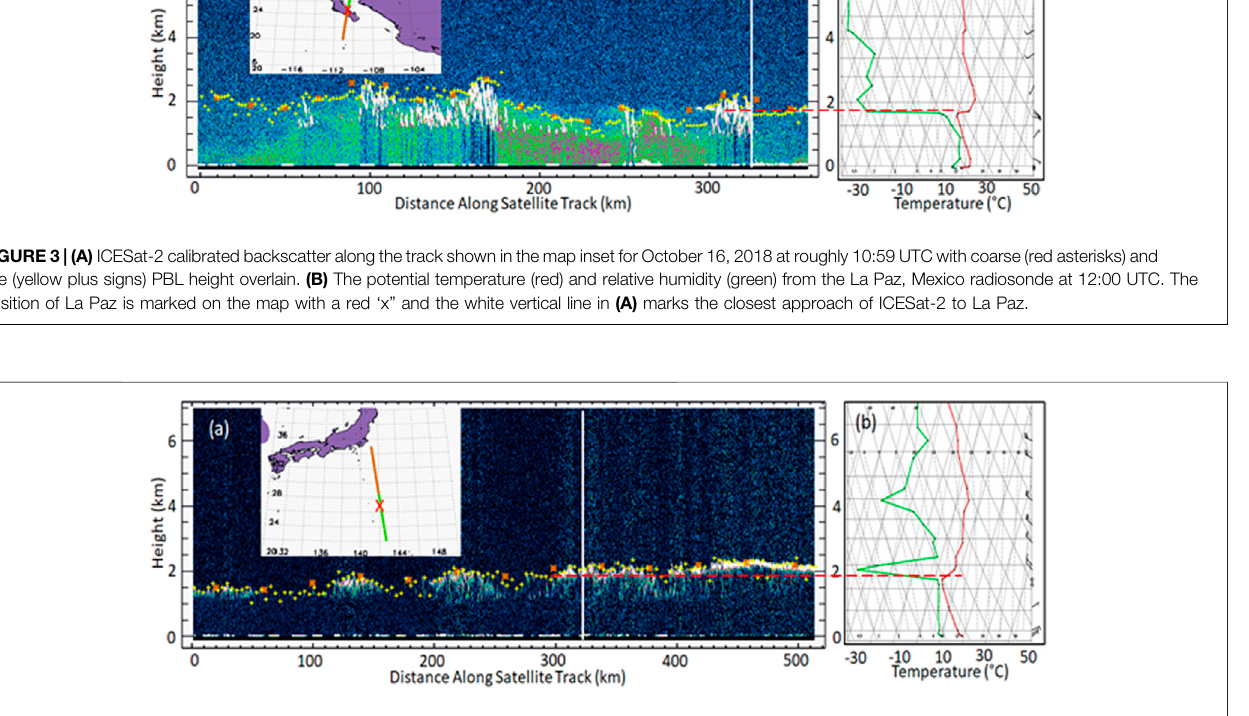
FIGURE 4 | (A) Same as Figure 3 except for an ICESat-2 pass on January 10, 2019 at 01:45 UTC over Chichijima, Japan and (B) the Chichijima radiosonde temperature (red) and moisture pro fi le (green) at 00 UTC.